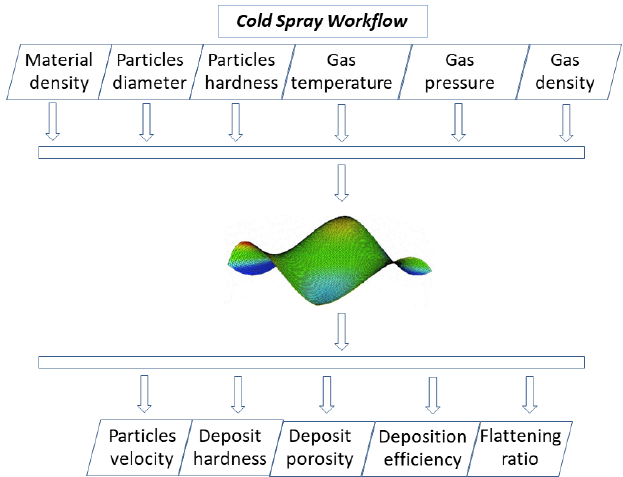
Figure 1. Workflow of the performed